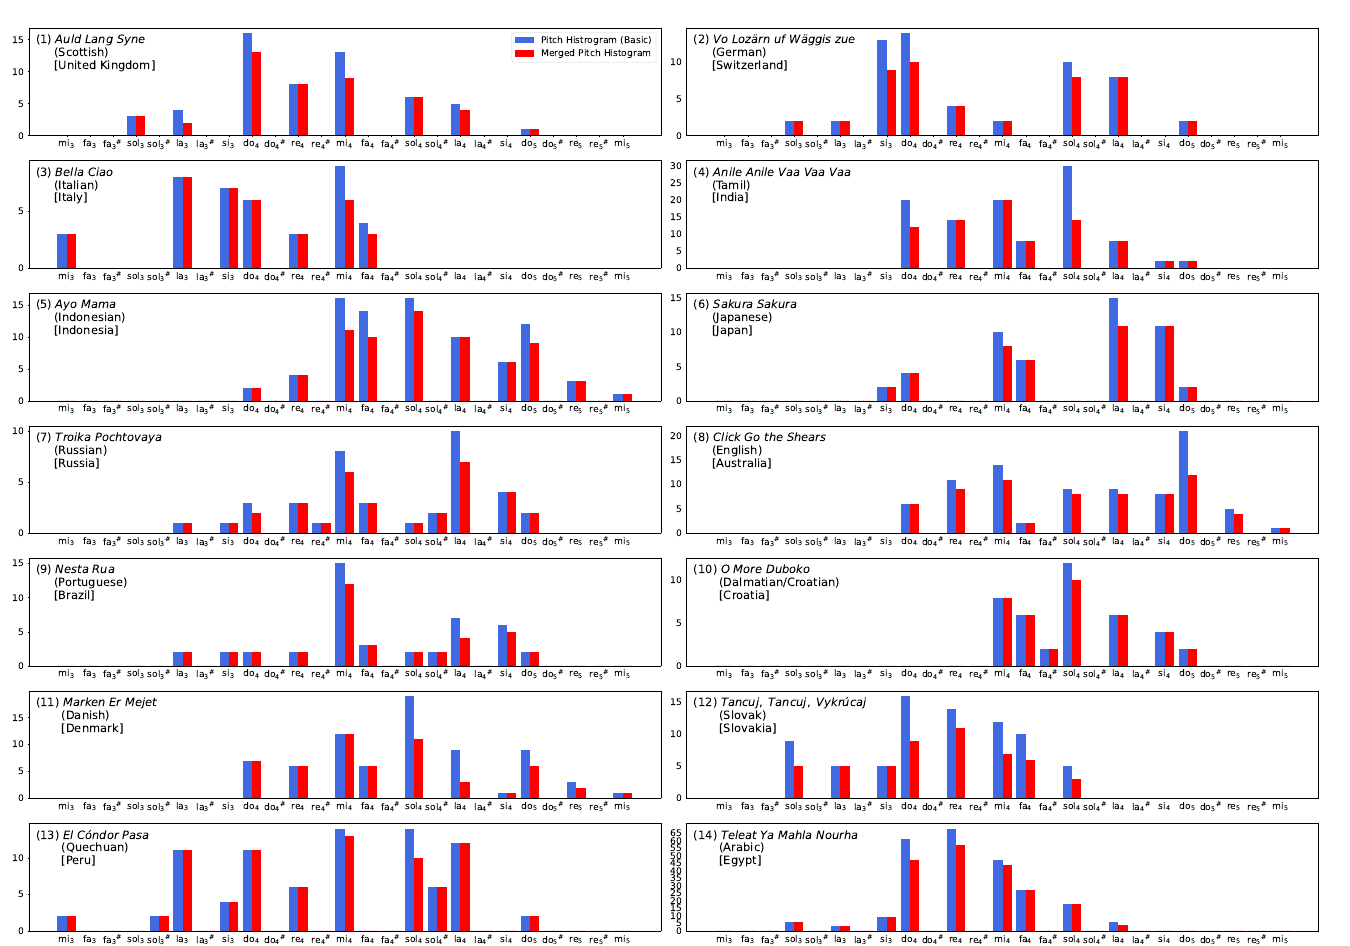
Figure 7. The movable do solfège-based basic and merged pitch histograms for fourteen well-known traditional folk songs from different countries, languages, and cultures, with the languages of the original version in curved brackets and the countries of the origin in square